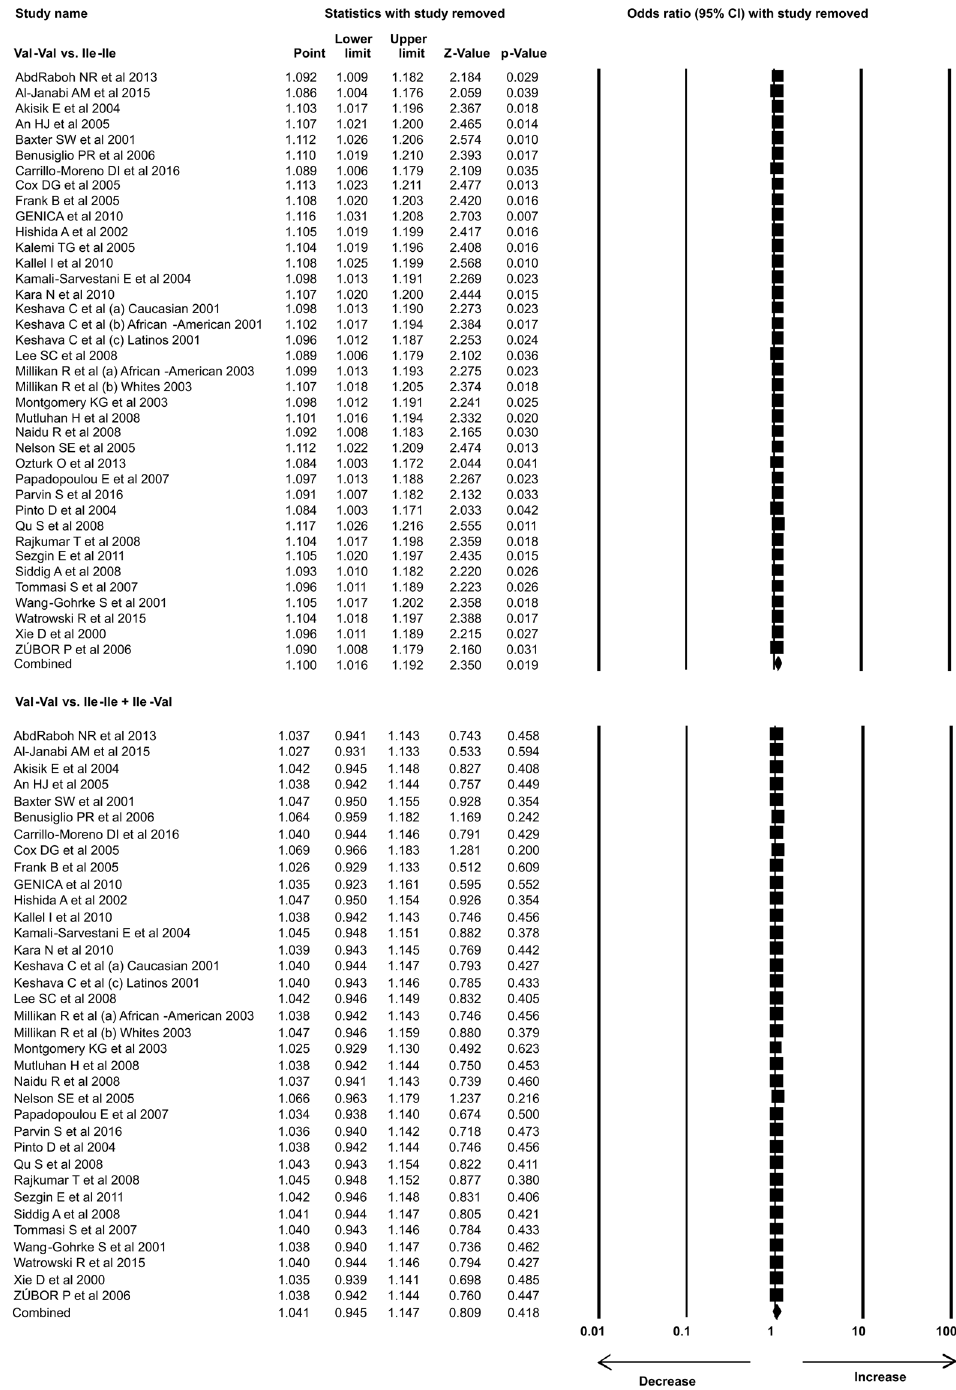
Figure 14. Sensitivity analysis: Sensitivity analysis with each study removal showing no effect on odds ratio (OR) in genotypic (Heterozygous: Ile-Val vs Ile-Ile and Recessive: Val-Val vs Ile-Ile + Ile-Val) analysis models of Her2 Ile 655 Val (rs1136201) gene